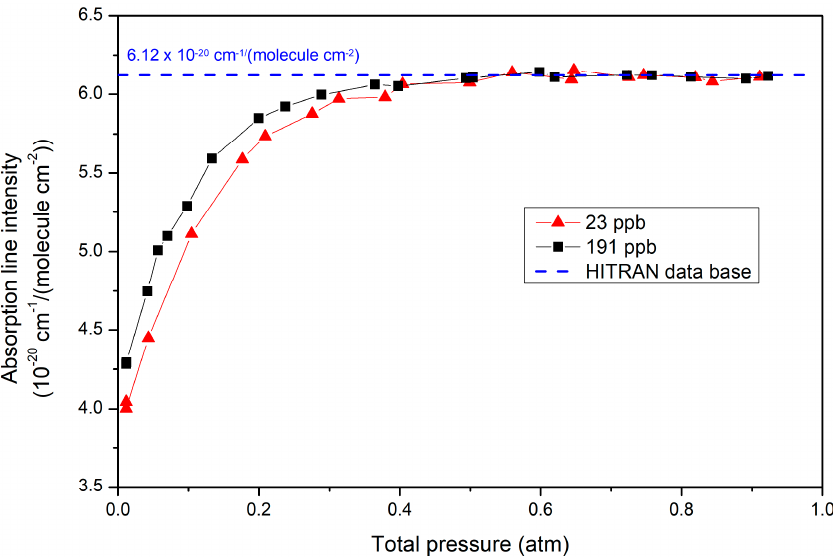
Figure 4. Evolution of NO absorption line intensity with pressure, for two different sample concentrations. One sample comes directly from a high-pressure tank (black squares), the other is obtained by flow dilution of gas from this tank with dry N 2 (red triangles). As explained in the text, the concentration values are derived from a scaling parameter used to adjust high-pressure plateau values to the HITRAN value.